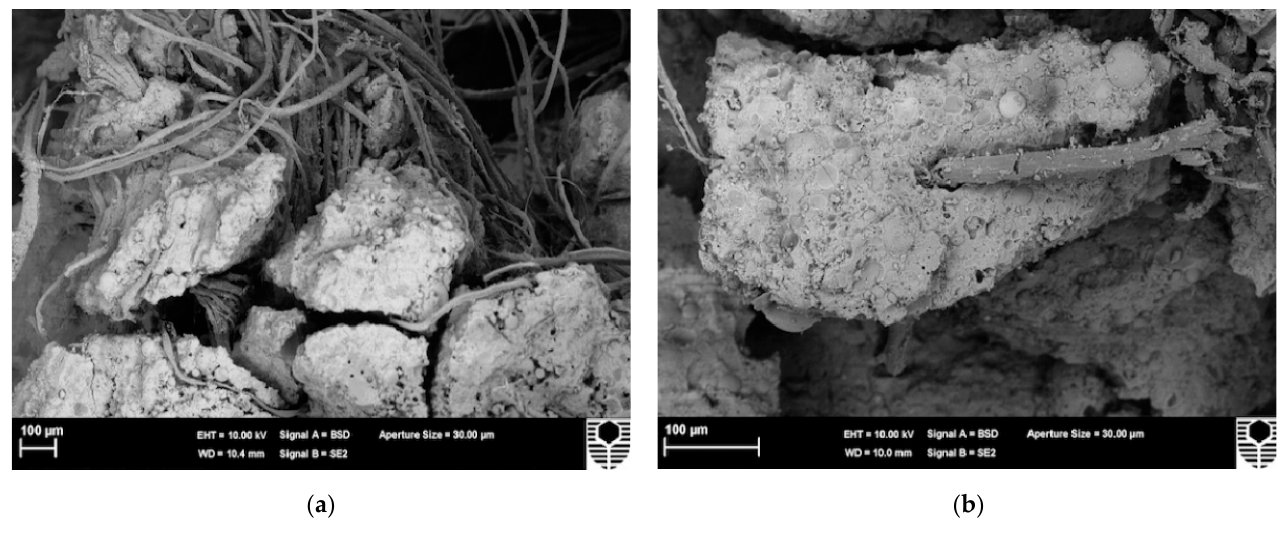
Figure 3. Microscopic morphology of interfacial adhesion between fibers and matrix. ( a ) Fiber bridging crack and fiber debonding; ( b ) Fiber adhesion to matrix and fiber fracture [51].